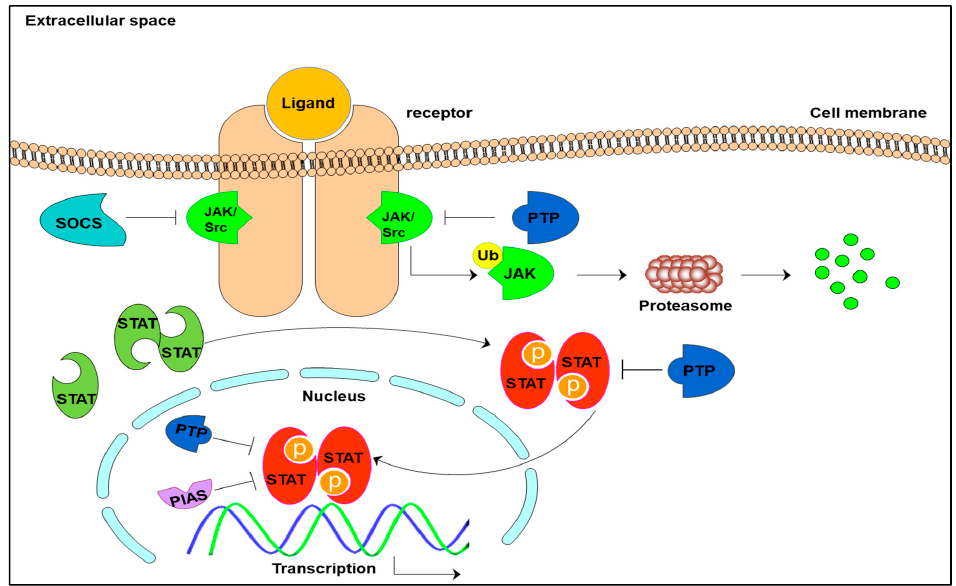
Figure 2. A schematic representation of STAT3 signaling cascade. STAT proteins are present in an inactive (unphosphorylated latent dimers) form in the cytoplasm. Upon ligand binding, the receptors dimerize to recruit upstream JAK/Src kinases. Phosphorylated tyrosine residues on the receptors provide a docking site to STATs and bring about their phosphorylation and